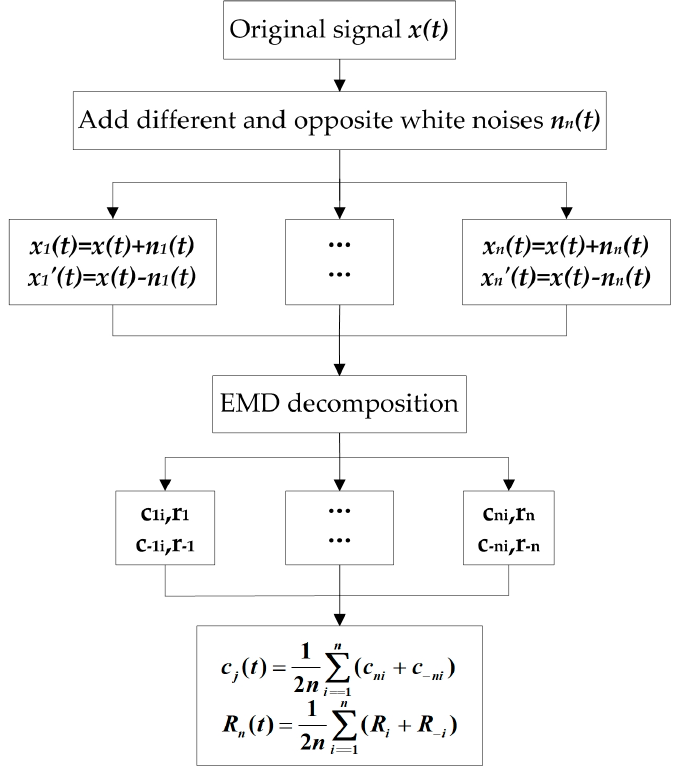
Figure 7. Flow chart of CEEMD decomposition.